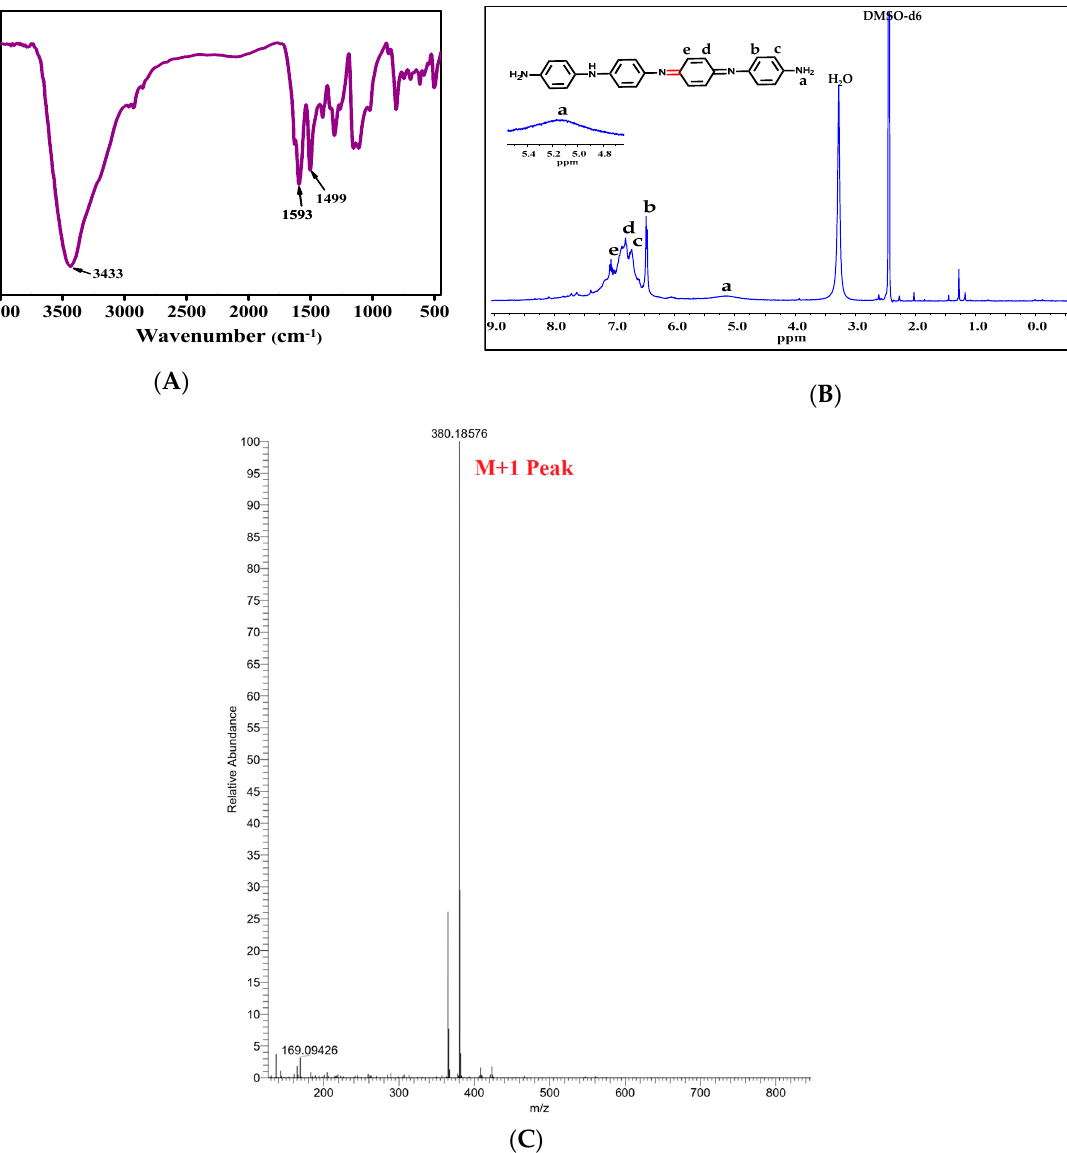
Figure 2. ( A ) FTIR, ( B ) Mass and ( C ) NMR Spectra of TANI .